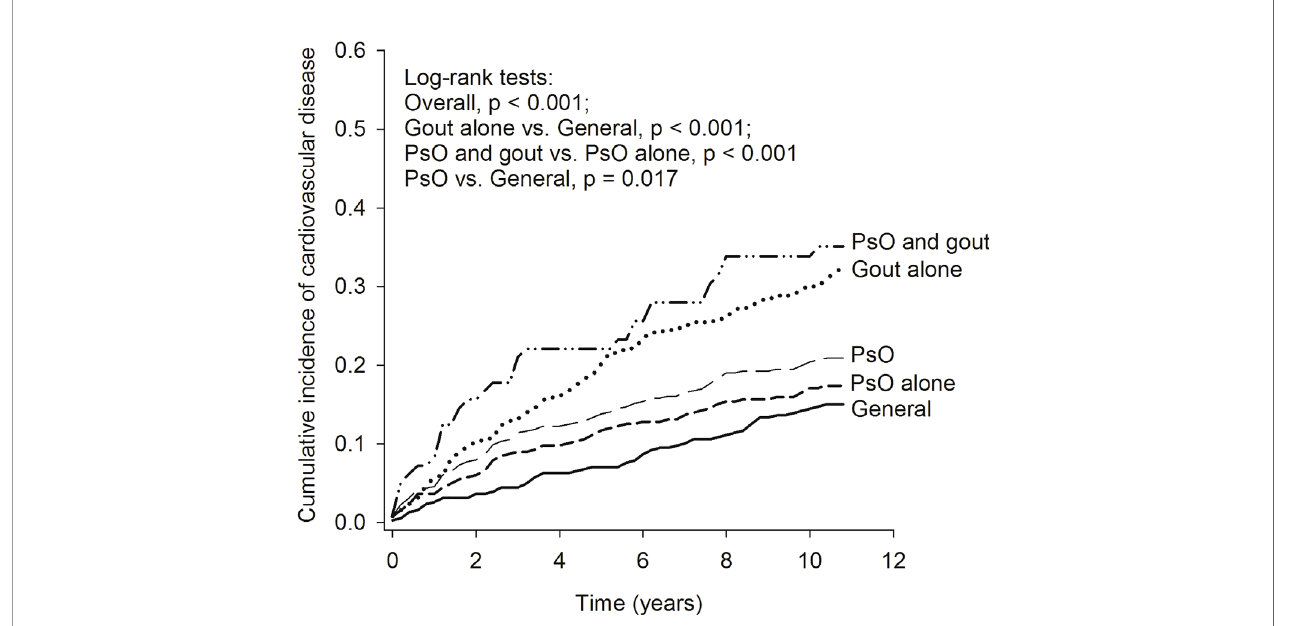
FIGURE 2 | Kaplan – Meier curve of cumulative incidence of cardiovascular diseases in the study groups. PsO, psoriasis.